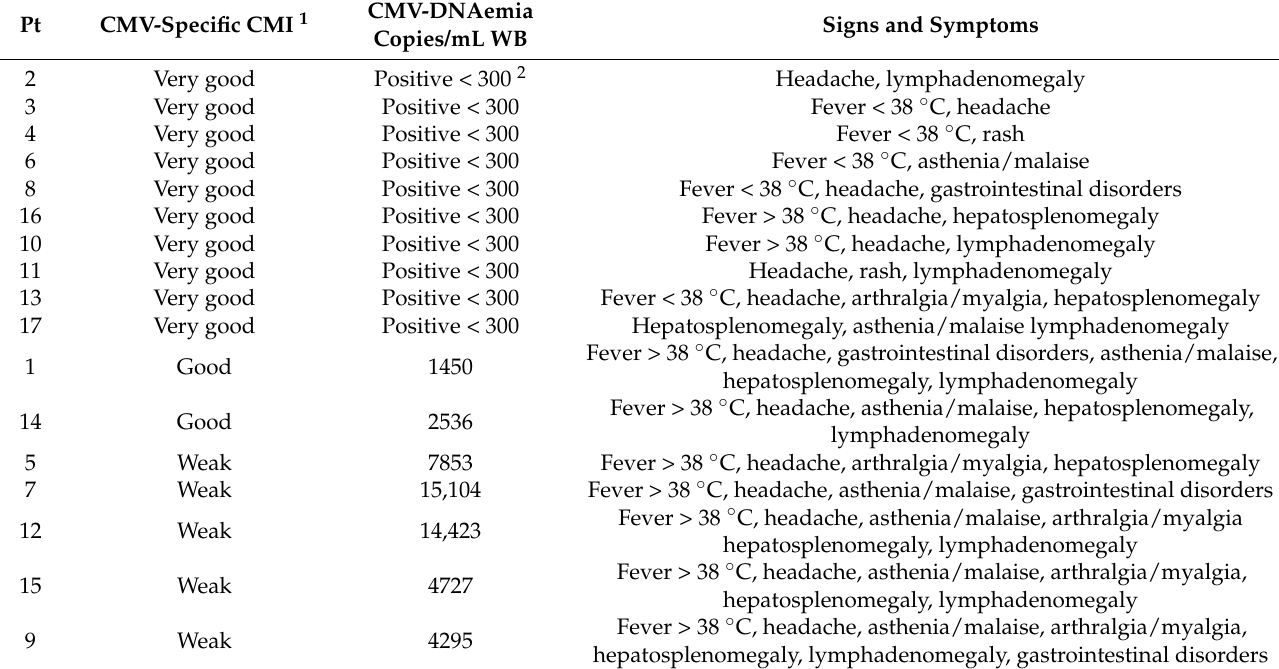
Table 2. Immunological, virological, and clinical findings in primary CMV infection within 20 days after the onset of infection.